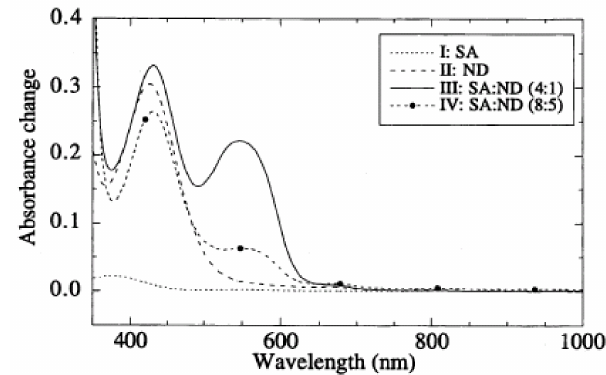
Figure 6. Absorption spectra of porous glass slides with Saltzman reagents, after exposure to 600 ppb NO 2 for 8 h (flow rate 1 L/min): with sulfanilamide (SA) (I), N , N -dimethyl-1-naphthylamine (ND) (II), SA and ND (4:1) (III), and SA and ND (8:5) (IV). Reprinted with permission from